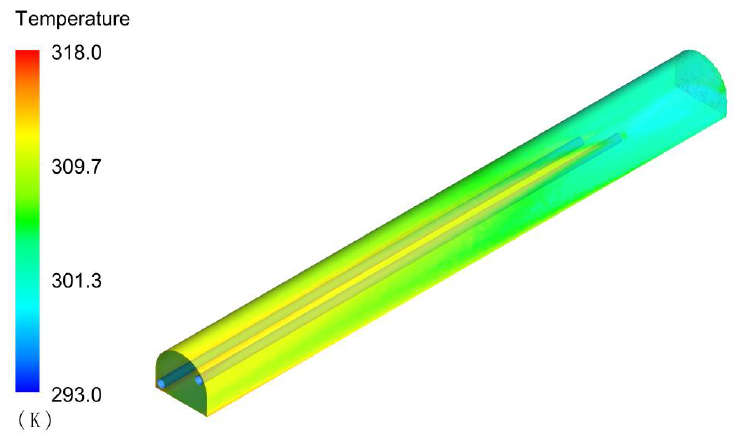
Figure 20. Three-dimensional distribution of Model 6 roadway temperature.